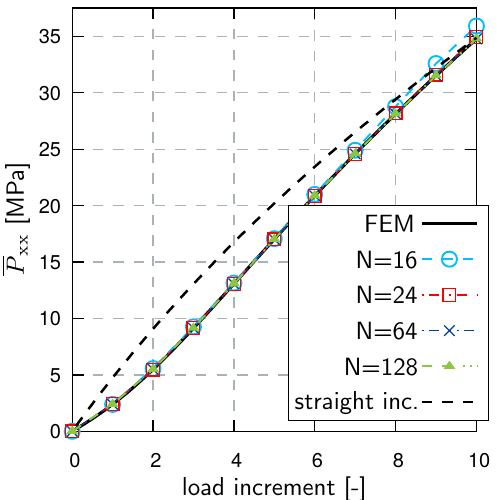
Figure 10. Stress curves for a microstructure with geometric stiffening (cf. Figure 9a), comparing the FEM result to the RB for various number of basis elements N . A similar microstructure without geometric stiffening but with the same final stress value (cf. Figure 9c) leads to the black dashed